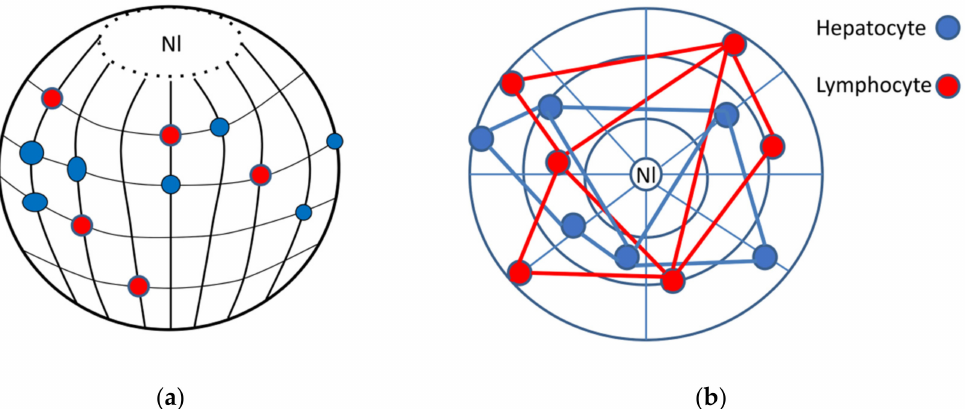
Figure 10. Replication timing and the tissue-specific “heterochromatin code” in a coordinate system for two different cell types (arbitrary hepatocytes and lymphocytes). ( a ) Hypothesis: The tissue-specific positional information is created by the latitude positions of silencing constitutive heterochromatin (CHR) clusters set (designed as red and blue balls) by replication timing upon the radial chromosome longitudes as the “3–4 D address” (to be specified by topology-associated domains (TADs)). ( b ) Principle sketch of the CHR clusters positions in the cell nucleus in a radial-concentric “geographic map” of coordinates (on 2D image) determined by Delaunay triangles.